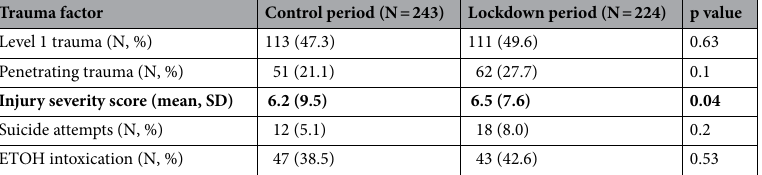
Table 2. Trauma characteristics of Trauma Activations during the control and lockdown period. Significant values are in bold. EtOH alcohol, SD standard deviation.